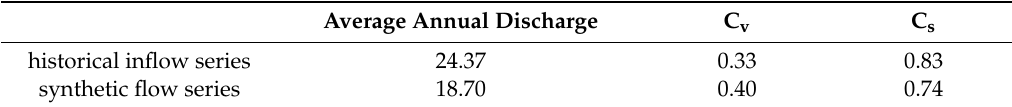
Table 3. Statistical parameters of the historical inflow series and the synthetic flow